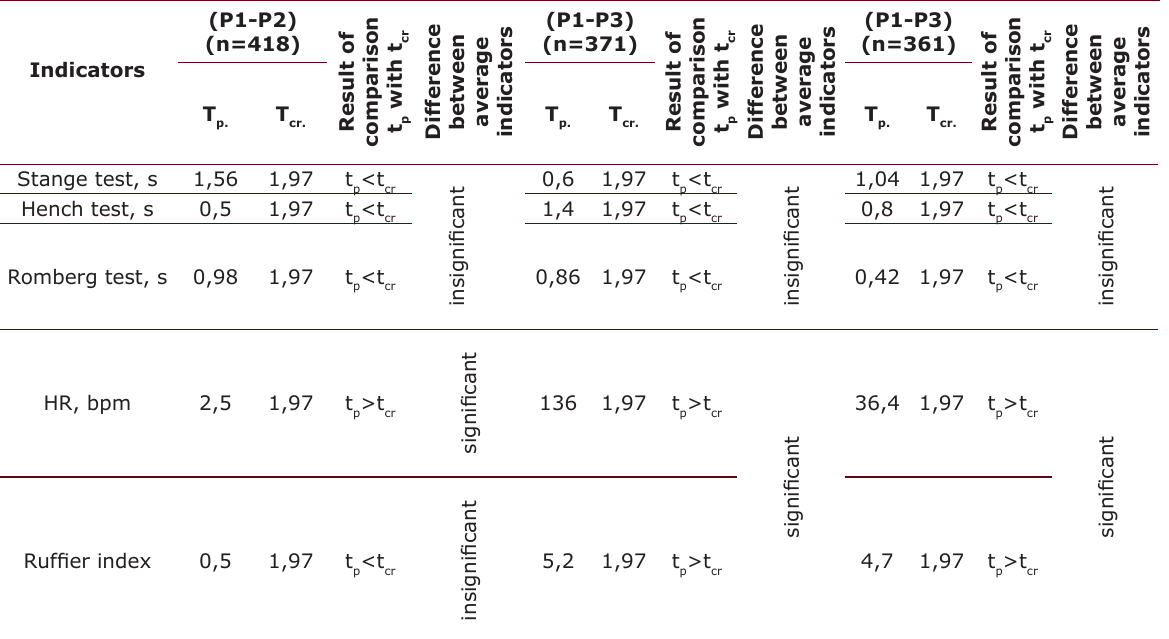
Table 4. Reliability of the difference in functional state indicators by (Student’s t-test)